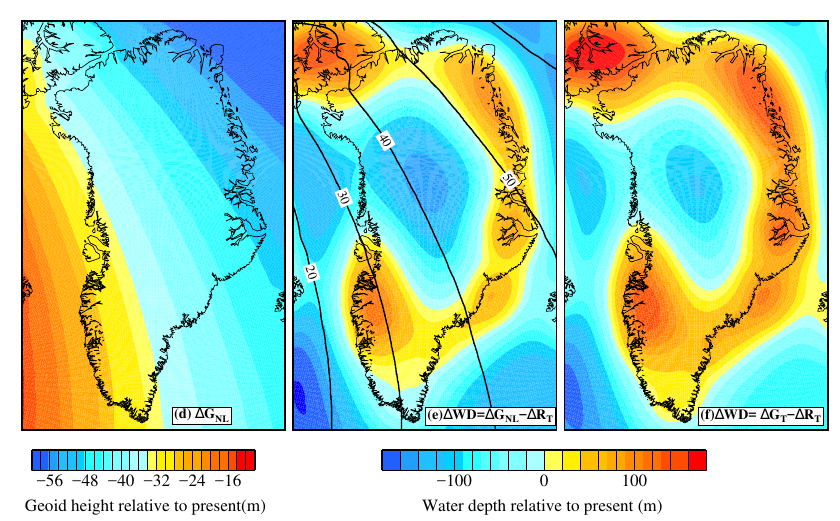
Figure 4. Illustration of the various components used within the calculation of the offline RSL forcing at 135ka BP. Panels (a–c) are the predicted (solid earth deformation) bedrock depth, (cid:49)R : (a) non-local component, (cid:49)R NL (No GrIS); (b) local component, (cid:49)R L (GrIS only); and (c) total signal. (cid:49)R T (d) Predicted non-local geoid signal, (cid:49)G NL (No GrIS). The predicted water depth ( W D ) signal is illustrated for (e) (cid:49)G NL − (cid:49)R T : combination of total predicted bedrock depth and non-local geoid. It is this signal which is used within all simulations. Contoured is the local signal, (cid:49)G L , which is not included. (f) Total water depth signal, (cid:49)W D . See text for extra details.